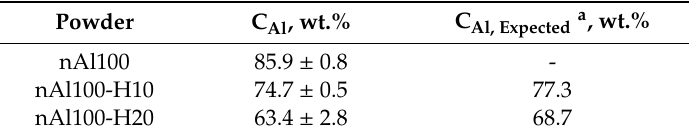
Table 4. Active aluminum content in the tested nAl powders.